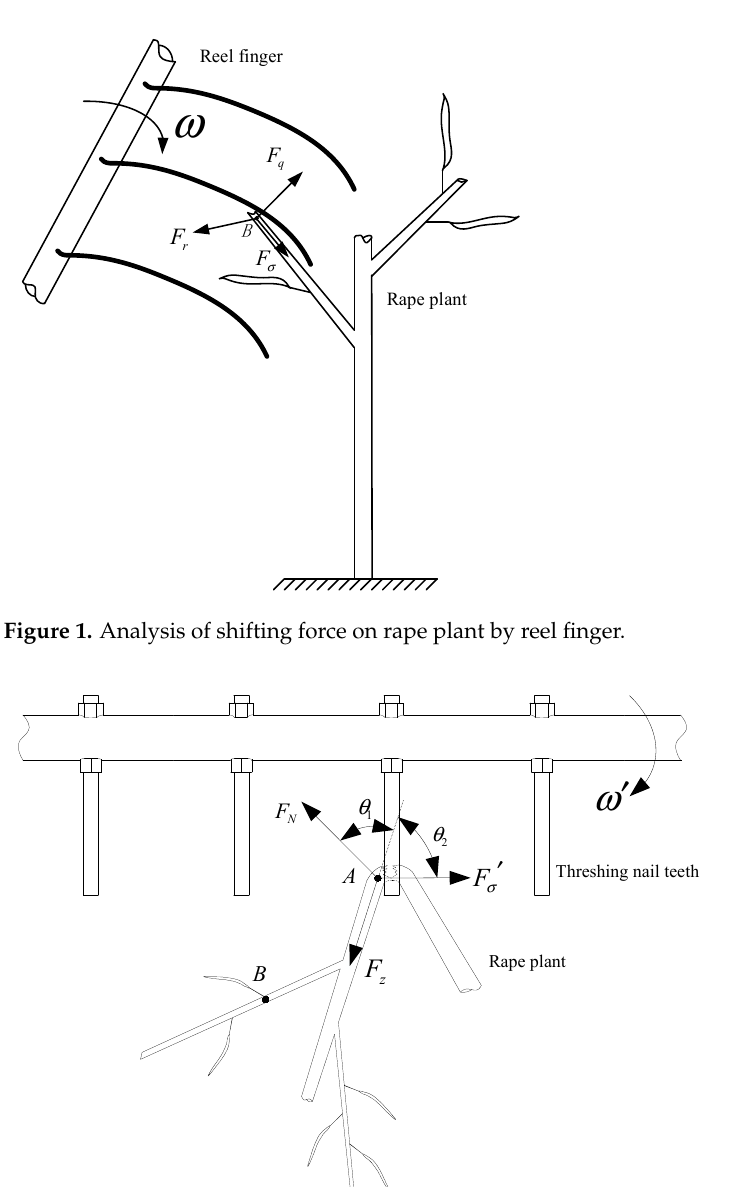
Figure 2. Analysis of hitting force on rape plant by threshing nail teeth. In Figure 2, the rape material fed into the threshing drum falls under the action of gravity and collides with the threshing nail teeth in the falling process. The threshing nail teeth are installed on the teeth rod and rotate around the center of the drum at speed ω . Due to the action of stalk epidermal fiber, the rape stalk will not be broken immediately after being impacted by the nail teeth. The stress analysis was carried out at the “ A ” point of the main stalk of rape. Point A is subjected to the tensile stress, F σ (cid:48) , of the partially broken stalk, the impact force, F N , of the threshing nail teeth on the stalk, and the resistance, F Z , along the moving direction of the stalk. The mechanical force analysis of the rape stalk in the direction of the moving speed and vertical speed can be expressed as follows: